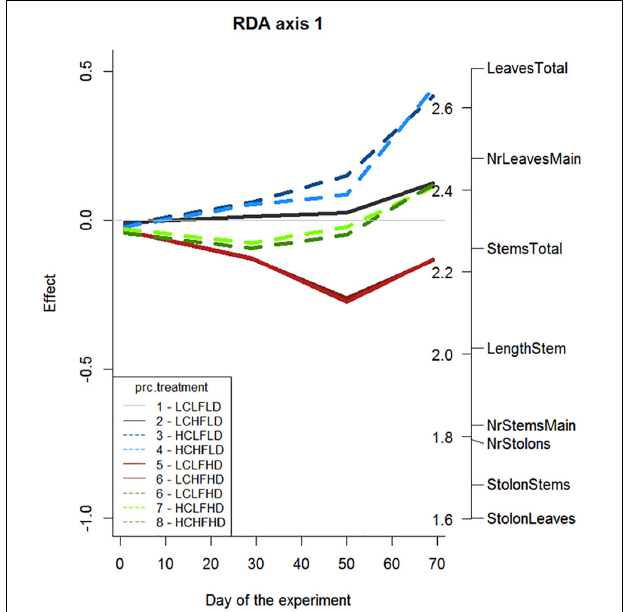
FIGURE 5 | Principal response curve (PCR) with the effects of the treatments on eight plant traits. On the right vertical axis the response variables are shown (number of stems and leaves on the main plant, stems and leaves that grew on the new ramets on the stolons, total number of stems and leaves, number of stolons and length of the longest stem) and their relative contribution to the observed pattern. The treatment with low CO 2 concentration, low flow velocity and a low DOC concentration is set as a reference situation (the horizontal grey line) and the effects of the other treatments are compared to this